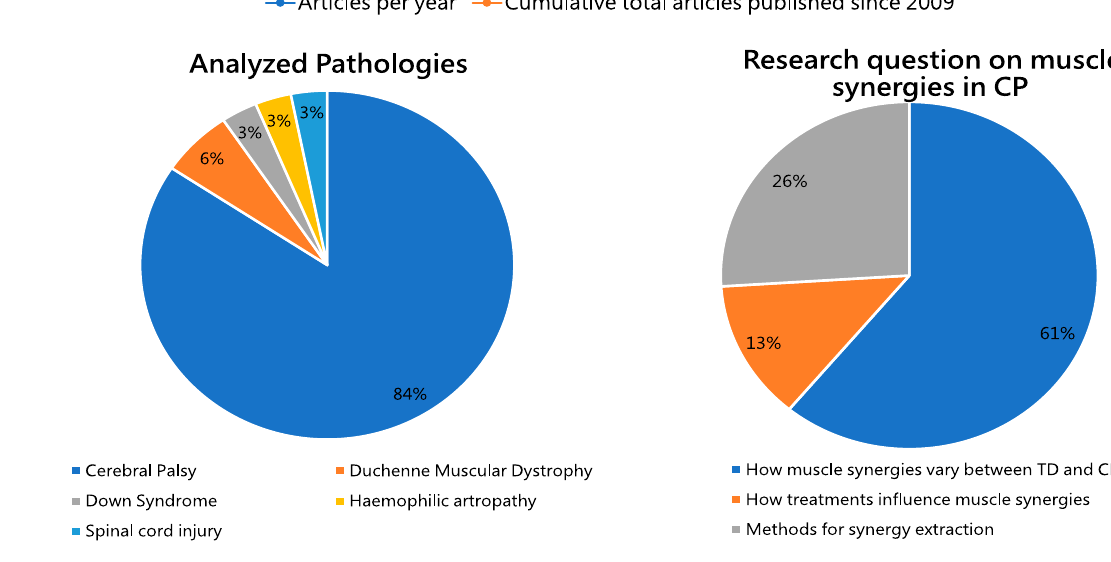
FIGURE 2 Upper panel: Number of studies on muscle synergies investigating children affected by developmental diseases per year, since 2009, is reported in blue.Cumulative numberofarticlespublishedonmusclesynergyanalysisinchildrenaffectedbyDDeligibleforthisreviewisshowninorange.Lowerleft panel: The percentages of studies exploiting muscle synergy analysis for the considered developmental diseases. Lower right: The main research questions analyzed in the available articles on muscle synergies in